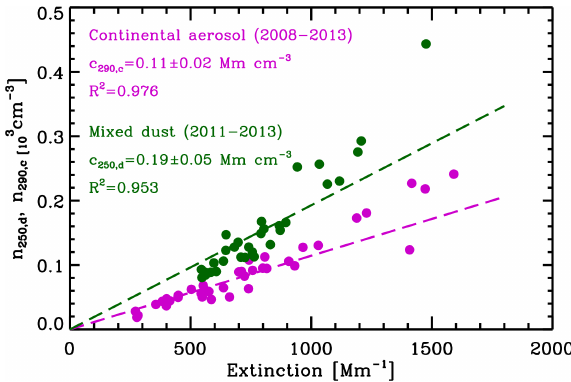
Figure 6. Relationship between extinction coefficient and large par- ticle (with radius > 250nm) number concentration n 250 , d for mixed dust and n 290 , c for continental aerosols over Wuhan. Each green point denotes a pair of daily averaged values for the dust occur- rence period of a dust-intrusion day (verified by ground-based po- larization lidar). Each purple point denotes a pair of daily aver- aged values during the period when Ångström exponent > 1 . 6 . The conversion factor c 250 , d = 0 . 19 ± 0 . 05Mmcm − 3 is obtained during 2011–2013, and c 290 , c = 0 . 11 ± 0 . 02Mmcm − 3 is obtained during 2008–2013 (see Eqs. 4 and 5 in Mamouri and Ansmann, 2016).